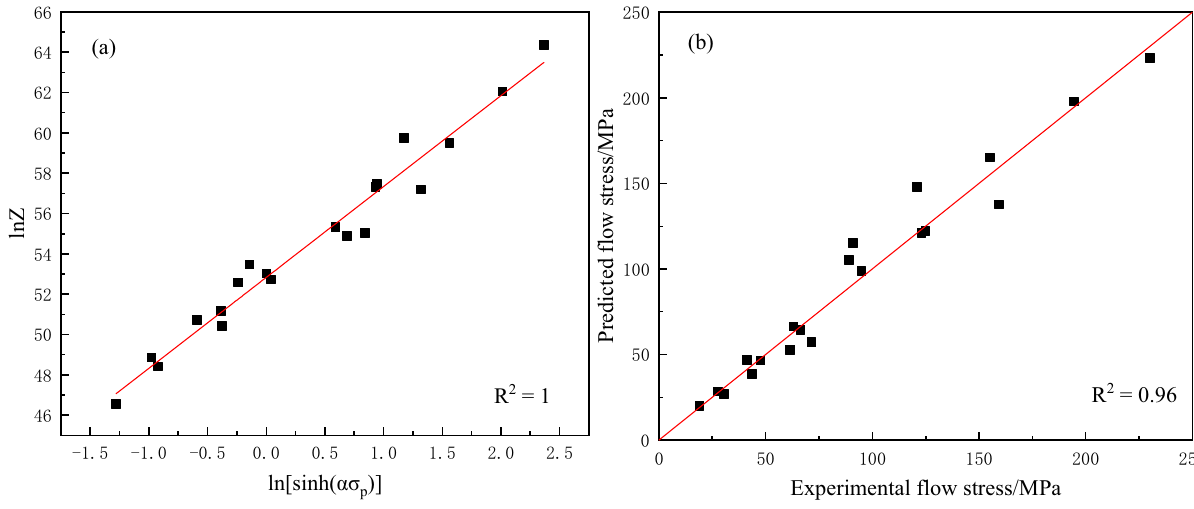
Figure 5: Constitutive equation fi tting results of the studied 9Cr3W3Co - ODS steels: ( a ) plots of ln Z − ln [ sinh ( ασ p )] ; ( b ) the relationship between the predicted peak stress and experimental peak